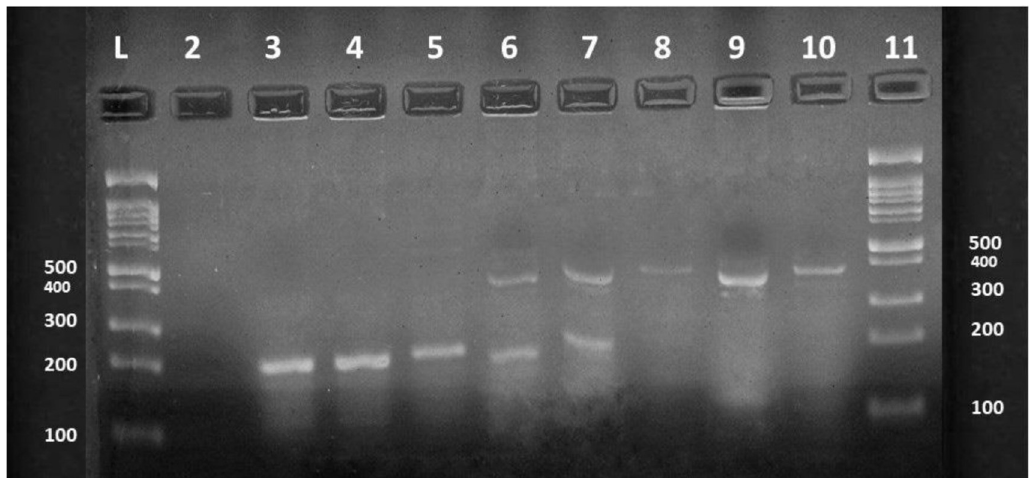
Fig 2. Detection of carbapenemase genes IMP, and VIM in carbapenemase-producing Gram-negative bacilli isolates, using multiplex PCR. Lanes 3–5 represent the positive IMP carbapenemase gene, Lanes 8–10 represent the positive VIM carbapenemase gene, Lanes 6 and 7 represent co-expression of IMP and VIM genes. The molecular size of the IMP and VIM genes are 232 and 390 bp respectively. Lane 1 and 11 are 1-kb DNA ladders. Lane 2 corresponds to the negative control.